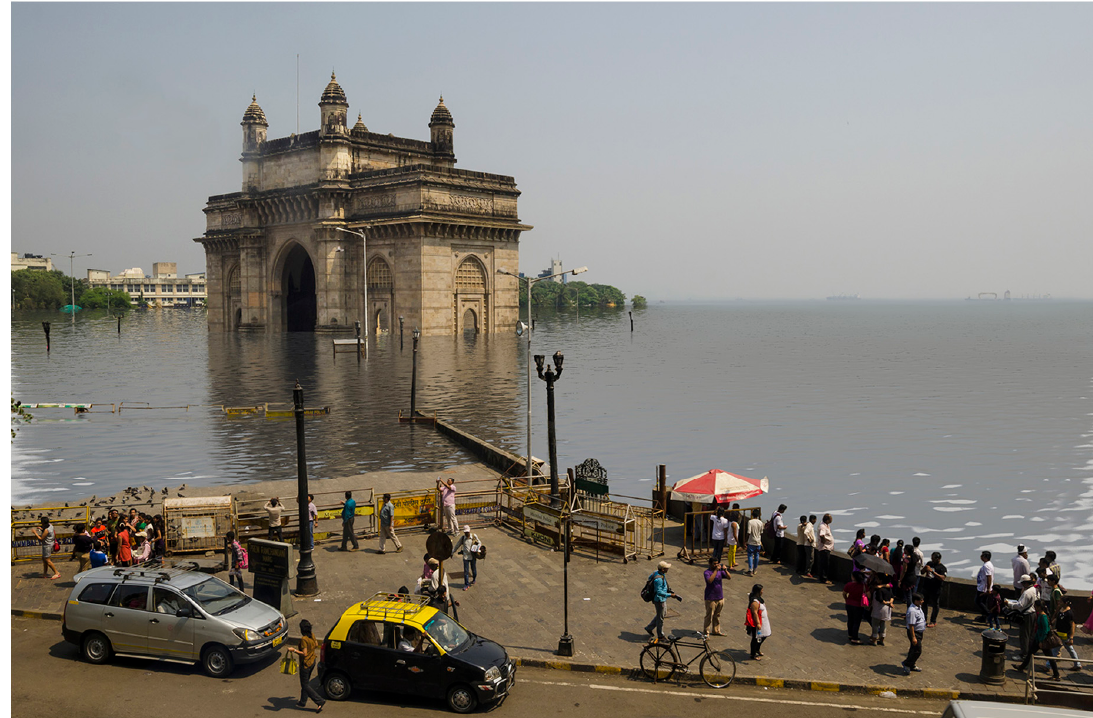
Figure 4. Climate Central’s image of Mumbai at 2 °C of warming.